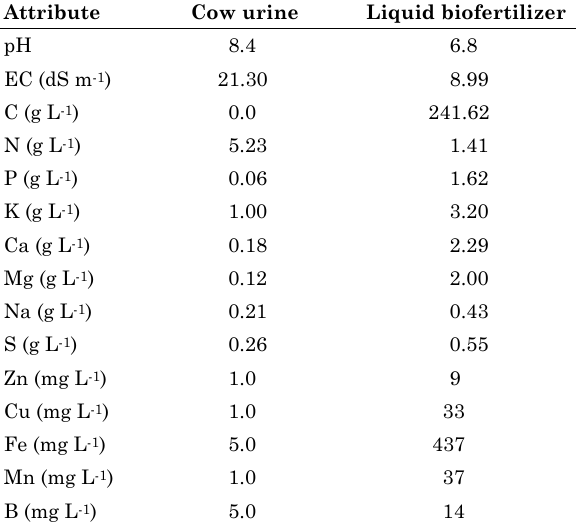
Table 1. Chemical composition of the organic fertilizers used in the